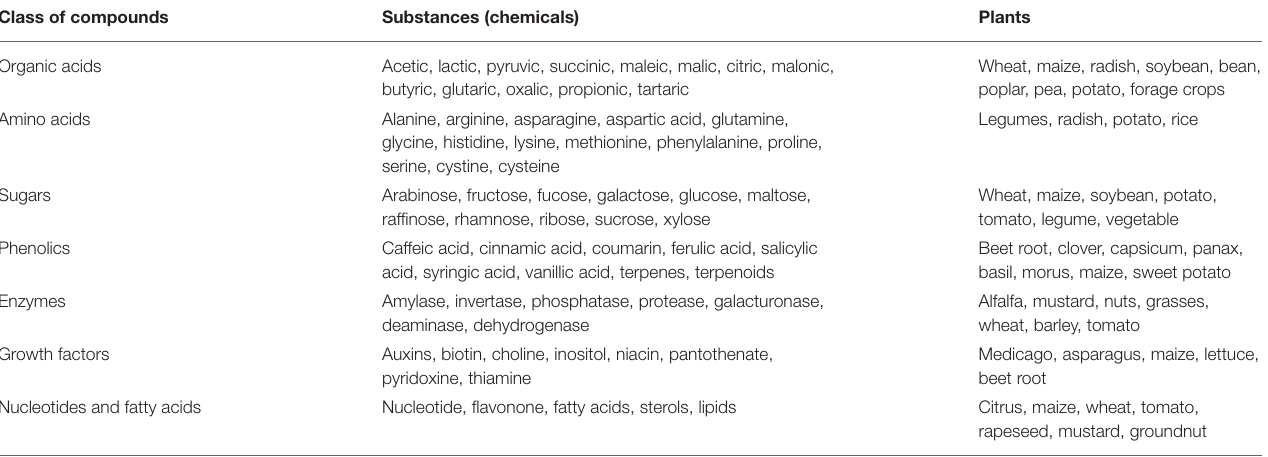
TABLE 1 | Compounds secreted by root (as root exudates) by different plants into the rhizosphere-soil vicinity. Class of compounds Organic